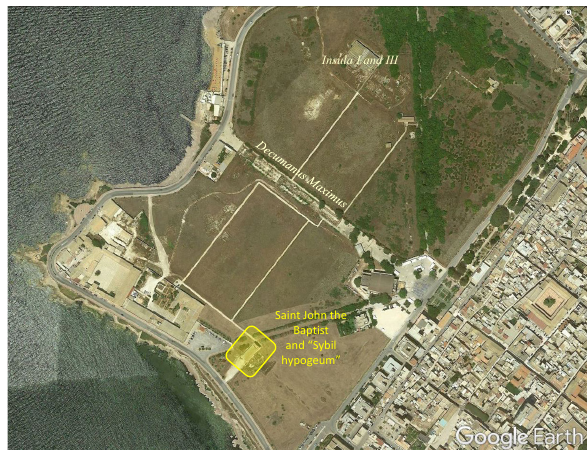
Figure 2. Localization of the “Sybil hypogeum” inside the Park (from Google Earth©).